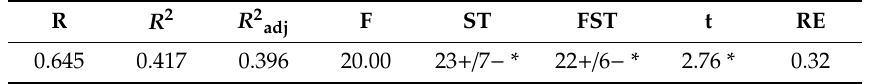
Table 2. Statistical characteristics of the verification of the streamflow reconstruction.